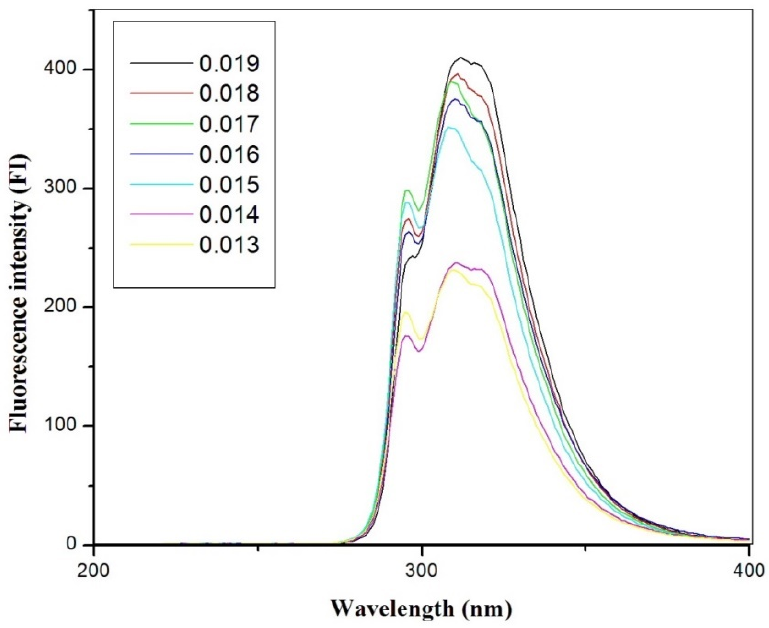
Figure 5. Fluorescence intensities (FI) versus wavelength for post-micellar concentrations of SDS in CAD + E ‐ OH .